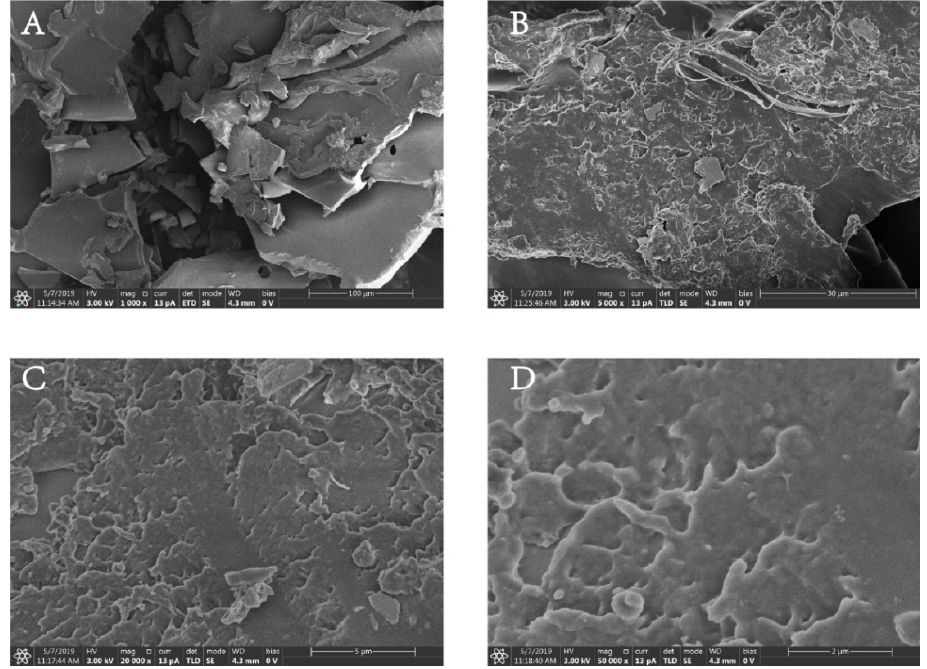
Figure 8. Scanning electron microscopic (SEM) images of PF40: ( A ) 1000 ×; ( B ) 5000 ×; ( C ) 20,000 ×; ( D ) 50,000 ×.